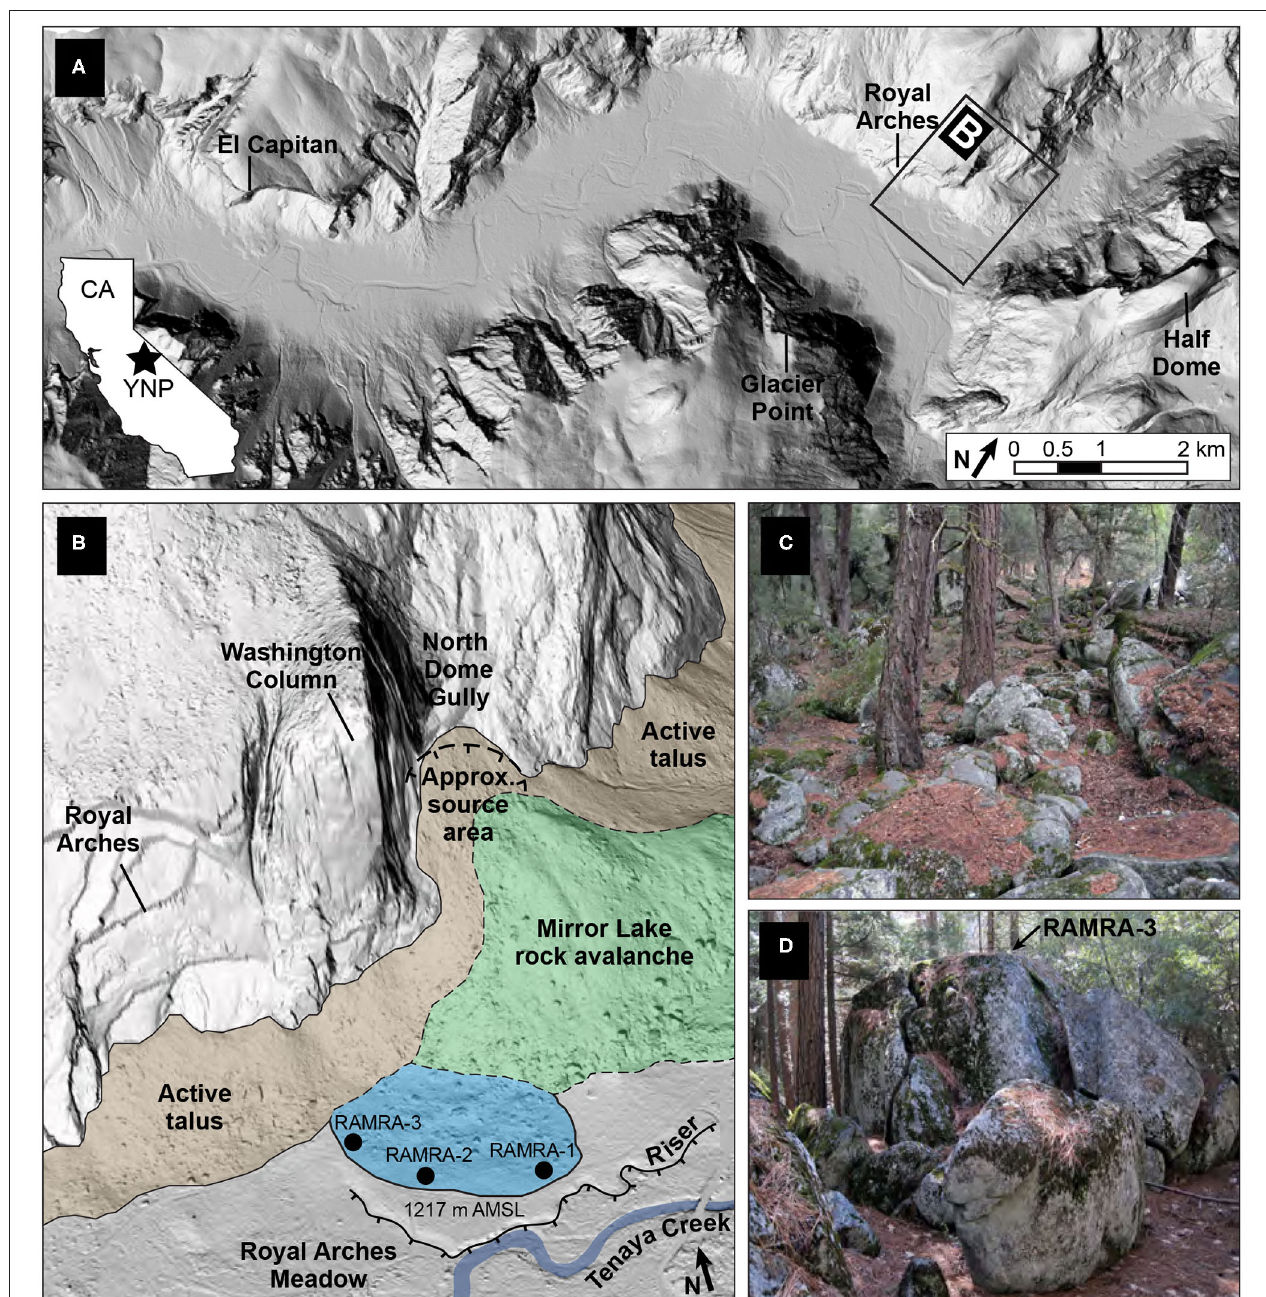
FIGURE 1 | Location and geologic setting of the Royal Arches Meadow rock avalanche. (A) Location of Royal Arches Meadow rock avalanche in eastern Yosemite Valley, Yosemite National Park (YNP), California (CA). (B) Oblique topographic hillshade, derived from 1 m filtered lidar data, showing the Royal Arches Meadow rock avalanche (blue), overlapping Mirror Lake rock avalanche (green), and active talus (brown), and terrace riser adjacent to Tenaya Creek. Black circles mark samples collected for cosmogenic 10 Be exposure dating. The width of the Royal Arches Meadow rock avalanche deposit is approximately 315 m . Extent of oblique view shown as box marked “B” in (A) . (C) Photograph showing bouldery topography typical of the exposed surface of the rock avalanche. (D) Photograph of a 3 m -tall boulder on the western margin of the rock avalanche sampled for cosmogenic 10 Be exposure dating (sample